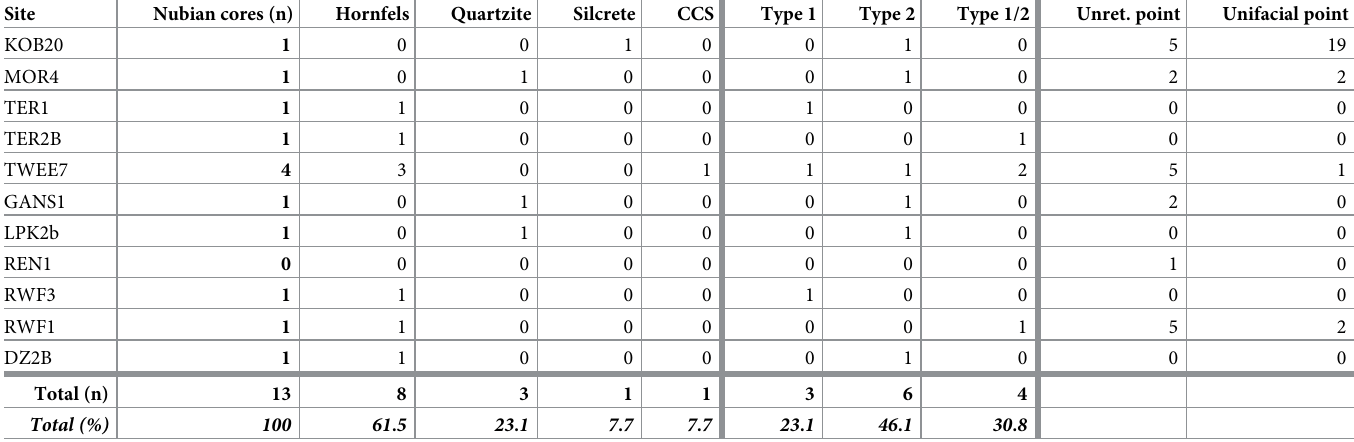
Table 14. Sites with Nubian technology (by raw material and core type) and associated unretouched and unifacial points in the Tankwa Karoo. Sites listed from west to east, locations shown in Fig 14. Site Nubian cores